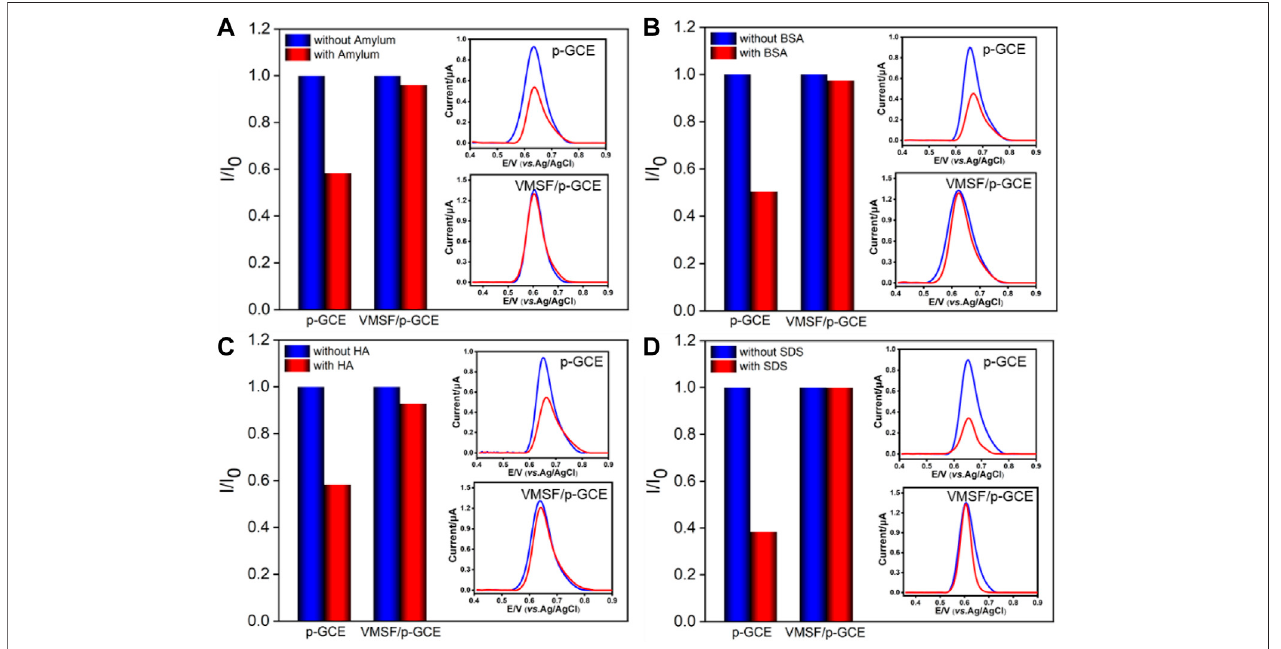
FIGURE 5 | Normalized oxidation peak current ratio on p-GCE and VMSF/p-GCE toward BPA (1.0 μ M). I and I 0 represent the currents obtained in the presence and absence of 50 μ g/ml of amylum (A) , BSA (B) , HA (C) , or SDS (D) in PBS (0.1 M, pH = 6). The insets are the corresponding DPV curves obtained on p-GCE and VMSF/p-GCE in the absence and presence of the fouling